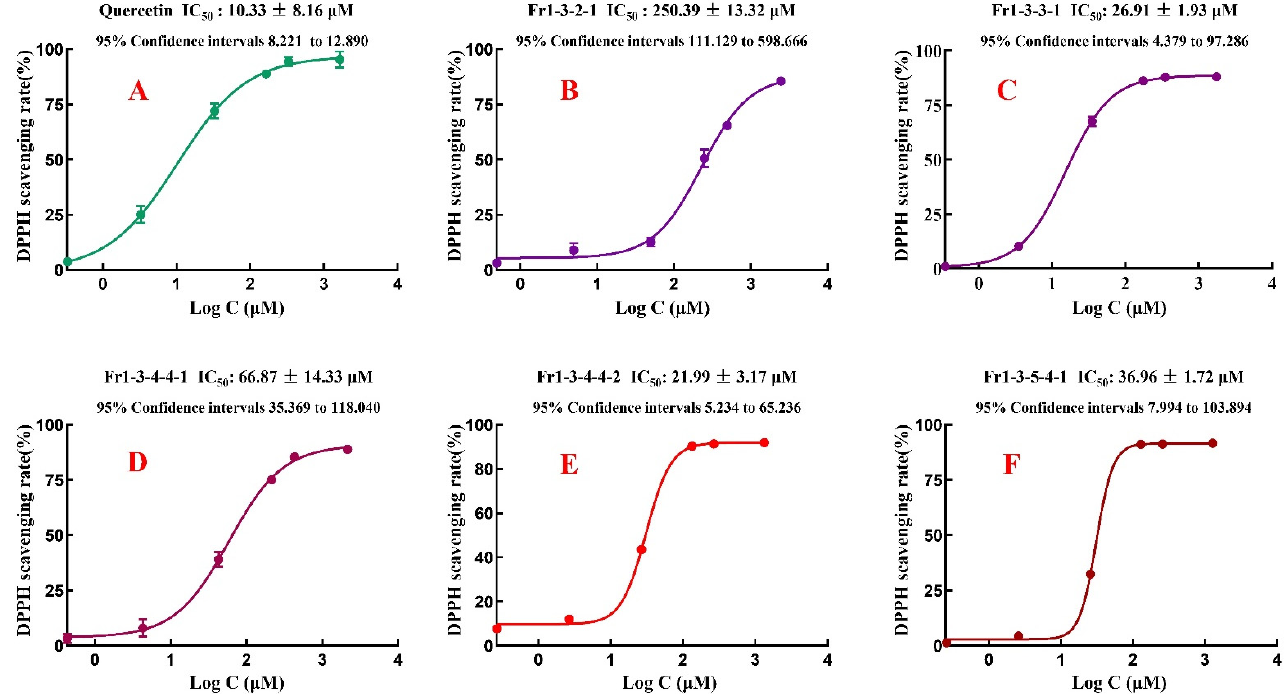
Figure 7. DPPH scavenging rate curves of quercetin ( A ), Fr1-3-2-1 ( B ), Fr1-3-3-1 ( C ), Fr1-3-4-4-1 ( D ), Fr1-3-4-4-2 ( E ), and Fr1-3-5-4-1 ( F ) and their IC 50